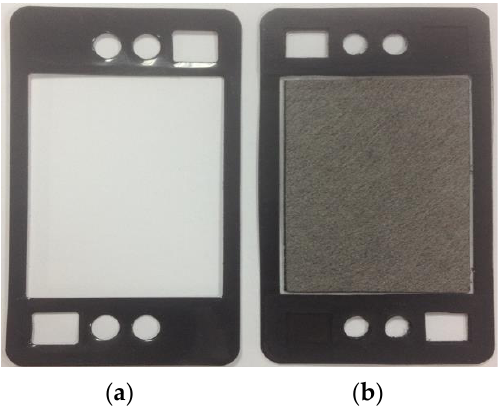
Figure 2. Bipolar plate module illustration in the study